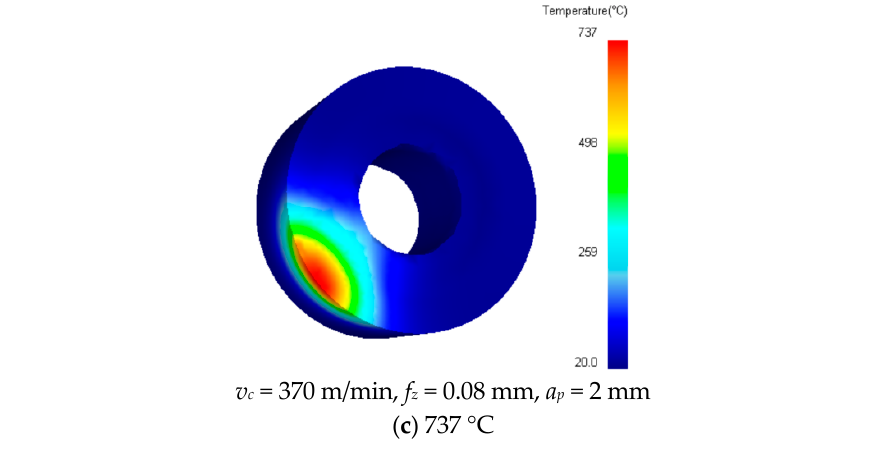
Table 4. Simulated and experimental results.